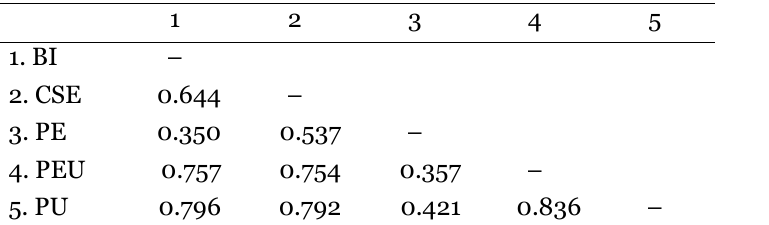
HTMT Criterion for Discriminant Validity